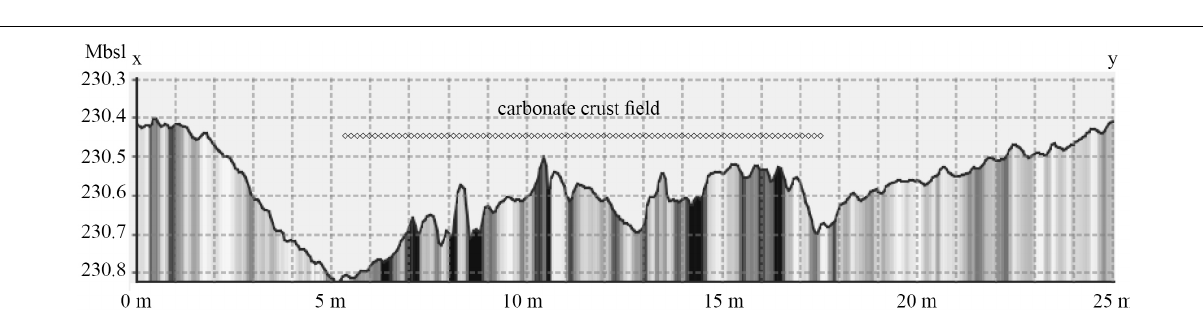
column data, showing that there were eight gas flares, grouped in two clusters which were c. 130 m